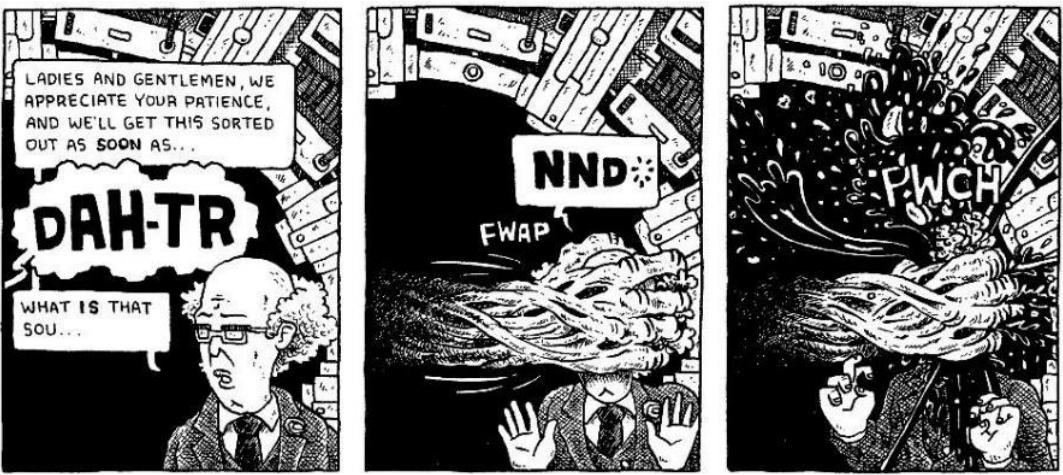
Figure 8. From Cotter, Nod Away , 144. Copyright, 2016, Joshua W Cotter.